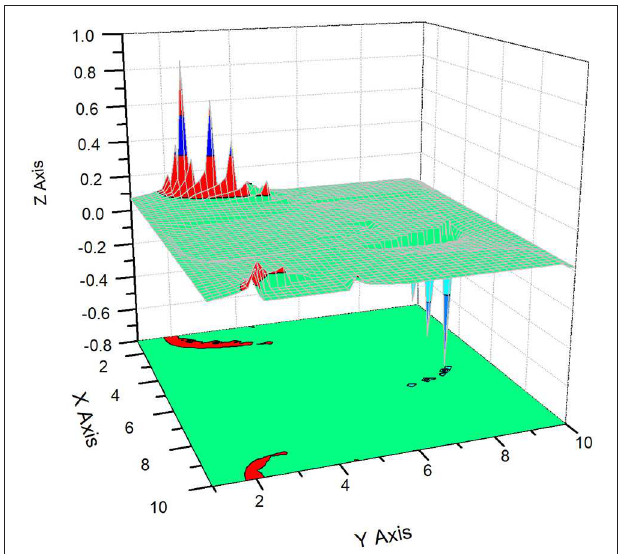
FIGURE 4 | Here we display the surface formed by the curve y 3 ( ϕ , θ ). The scale is similar to that of the previous figures.